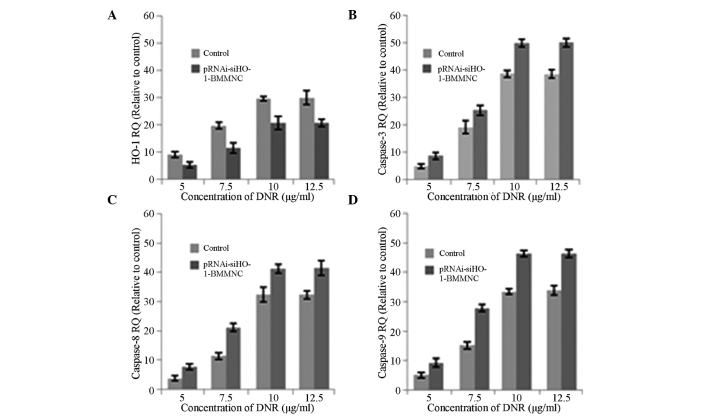
HO-1 and caspase-3, -8 and -9 mRNA expression was detected by quantitative polymerase chain reaction. (A) HO-1 mRNA expression changed depending on the dose of DNR. The expression level increased with rising DNR concentration and peaked in the presence of 10 μg/ml DNR. Expression levels of (B) caspase-3, (C) caspase-8 and (D) caspase-9 mRNA in the pRNAi-siHO-1-BMMNC group were higher than those in the BMMNC (control) group at each DNR concentration, the differences in the mRNA expression levels above were statistically significant (P<0.05). Expression levels increased with rising DNR concentration and peaked in the presence of 10 μg/ml DNR. HO-1, heme oxygenase-1; DNR, daunorubicin; BMMNC, bone marrow mononuclear cell.